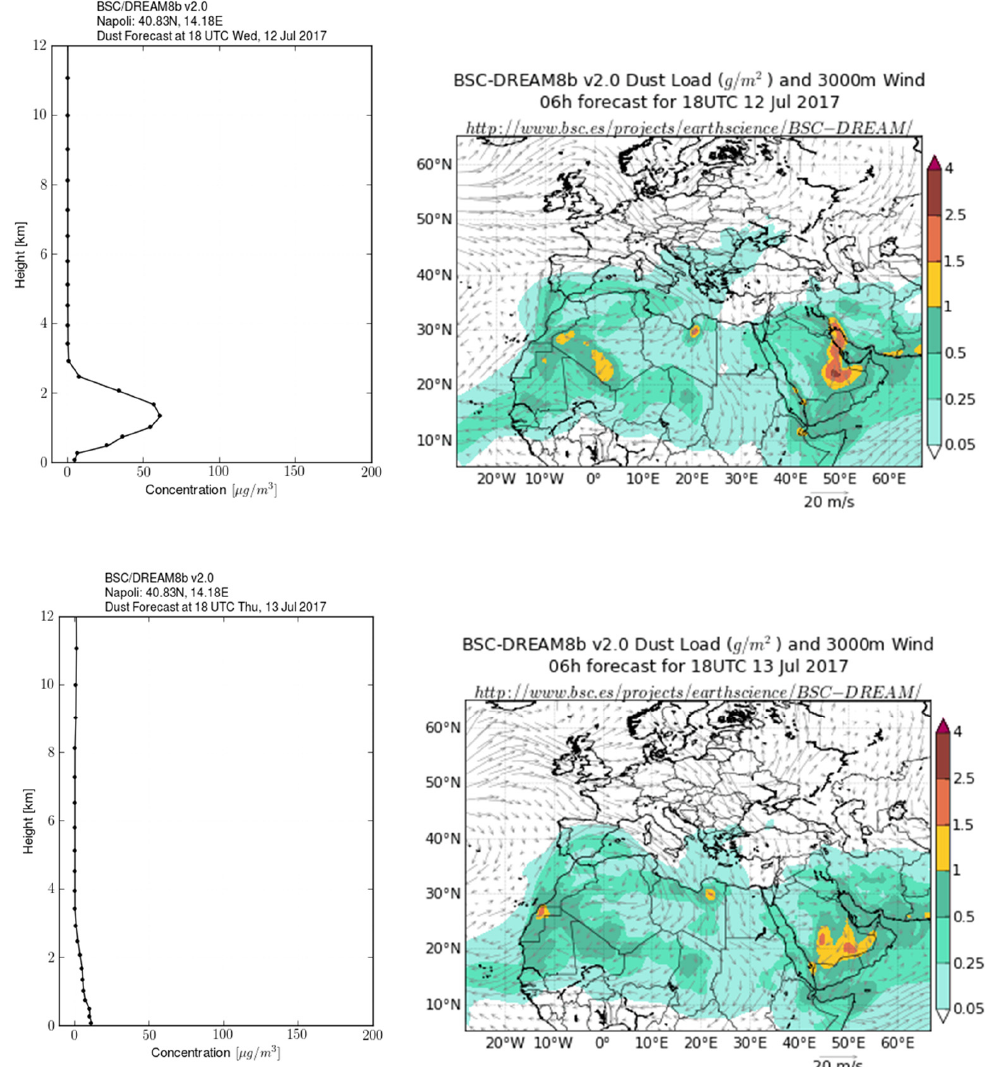
Figure 3. BSC-Dream dust forecast model results corresponding to low-level dust concentration (µg m − 3 ) (on the left) and dust load (g m − 2 ) (on the right) for 12 and 13 of July 2017.